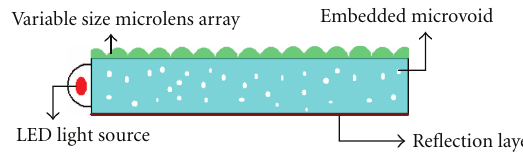
Figure 1: Design of optical film.